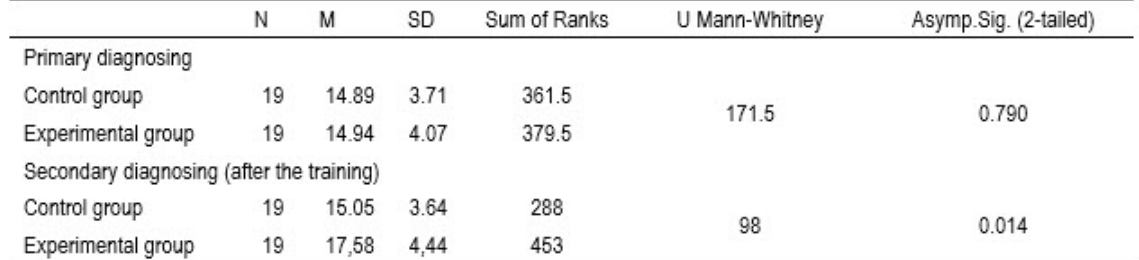
Statistical significance of differences in the level of ability to technologize the pedagogical process in the experimental and control